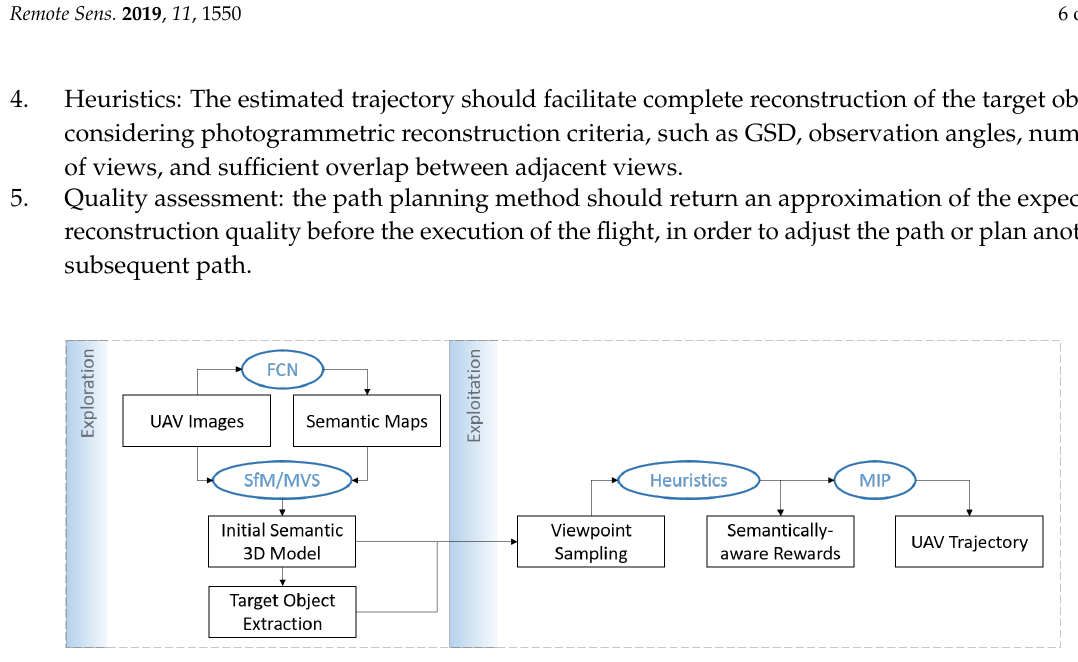
Figure 2. Overview of the proposed workflow of our UAV path planning approach. Based on a exploration flight at a safe altitude, the captured images are segmented and fused to an initial semantic 3D model. After selection of the target object, numerous camera viewpoints are sampled and assessed according to their eligibility for the reconstruction process, while the semantic information of the environment assigns restricted or prohibited airspaces for the UAV. Finally, a discrete graph-based optimization estimates the optimal semantically-aware trajectory which ensures a high-quality 3D model of the target